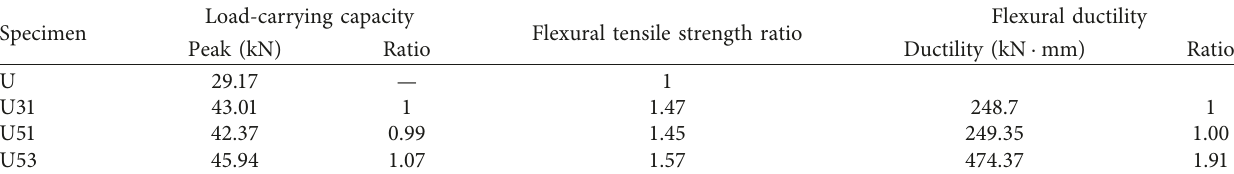
Table 2: Summary of test results (without reinforcing bar).